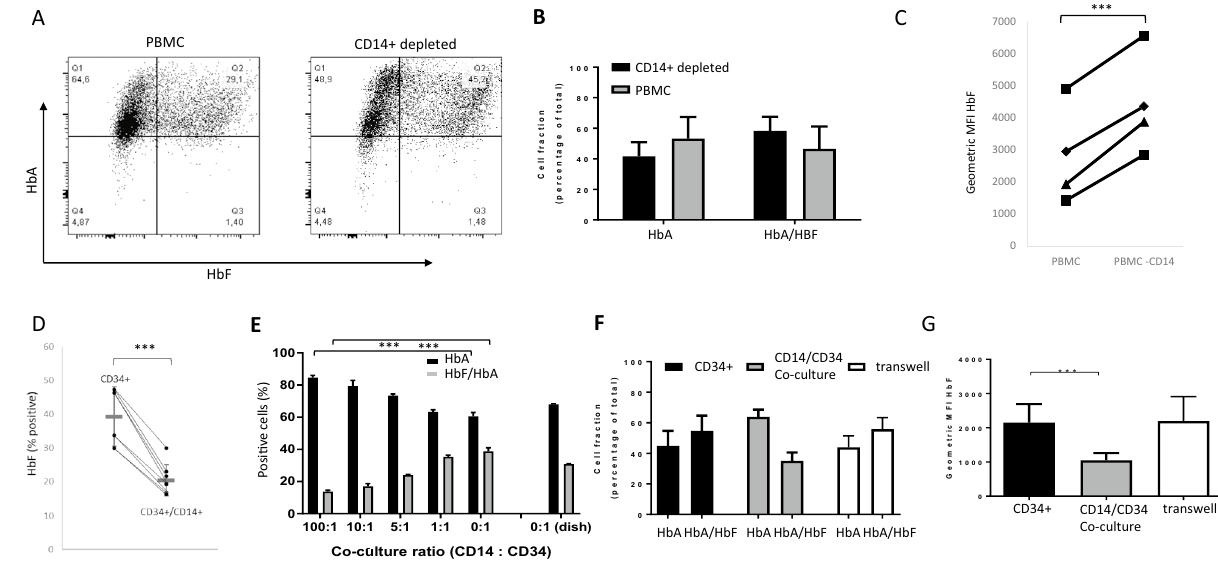
Figure 2. CD14+ monocytes promote repression of HbF expression in erythroblasts. ( A ) PBMC and PBMCs depleted for CD14+ cells were cultured to obtain hemoglobinized erythroblasts as indicated in material and methods. The expression of HBB1 and HBG1/2 was assessed by flow cytometry. Dot plots show representative erythroblasts cultured from PBMC (left) or PBMC depleted for CD14+ cells (right; anti-HBB1, y-axis; antiHBG1/2, x-axis). ( B ) Bar graph shows the percentage of events in Q1 (HbA cells) and Q2 (HbA/HbF cells) from ( A ) for erythroblasts derived from PBMC (grey bars) or from CD14+ depleted PBMC (black; n = 3). ( C ) Mean fluorescence intensity of HBG1/2 from the data presented in; N = 4; paired student TTEST; *** = p < 0.01 ( A ). ( D ) CD34+ cells and CD14+ cells were purified from PBMC and co-cultured or not as indicated in the graph. The plot depicts the HbF percentage in the different culture conditions and lines indicate the paired samples (N = 4 donors in duplicate; a paired T-test, *** = p < 0.01). ( E ) CD34+ and CD14+ cells were purified from PBMC and co-cultured using specific ratios of CD14+ cells to CD34+ cells as indicated on the x-axis (CD14+ :CD34 +). Bar graphs represent the percentage of cells that are HBB1 positive (Black, HbA) or HBB1/ HBG1/2 double positive (grey, HbA/HbF) as determined by flow cytometry (supplemental Fig. 3; n = 3; student TTEST p < 0.01). ( F , G ) CD34+ and CD14+ cells were purified from PBMC as indicated in material and methods. Cells were co-cultured using 100:1 CD14+ to CD34+ ratio in full contact (grey bars), separated by transwells (white bars). The black bars represent CD34+ cultured without CD14+ cells as a control. Bar graphs in ( F ) represent the percentage of cells that are HBB1 positive (HbA) or HBB1/HBG1/2 double positive (HbA/ HbF) as determined by flow cytometry (n = 3). Bar graph in ( G ) depicts the geometric mean fluorescence of HBG1/2 expression (HBF) as measured by flow cytometry (n = 3, ***p < 0.01; Student’s